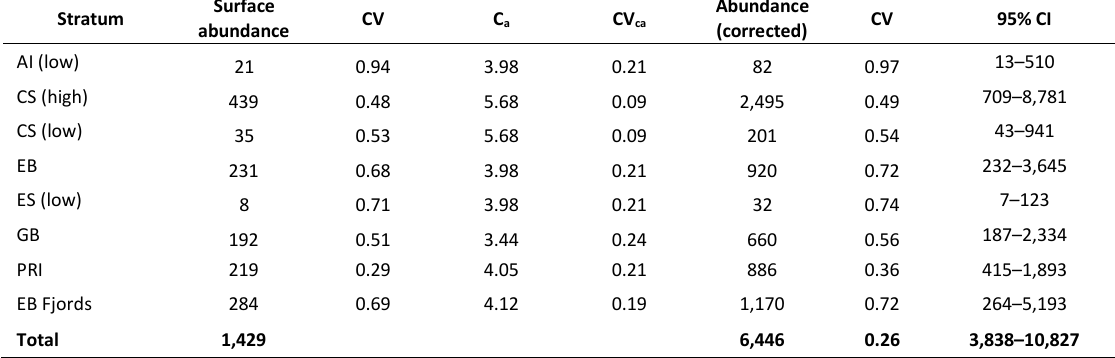
Table 3. Abundance estimates by stratum. ‘ Surface abundance ’: corrected only for perception bias . ‘ Abundance (corrected) ’ includes a correction factor C